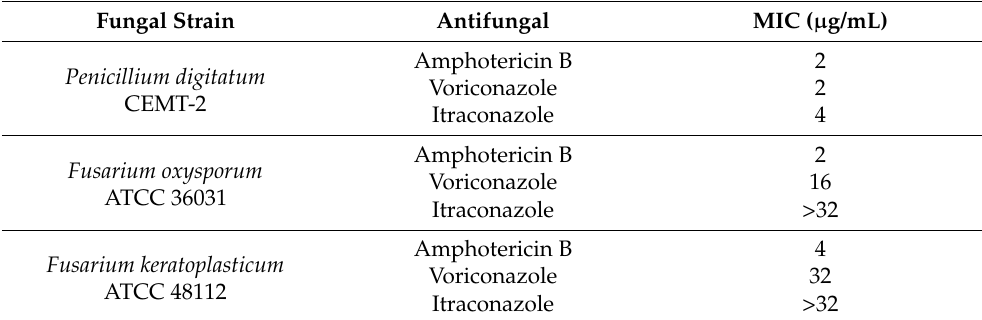
Table 2. Results of in vitro antifungal susceptibility test of the strain Penicillium digitatum CEMT-2. Fungal Strain